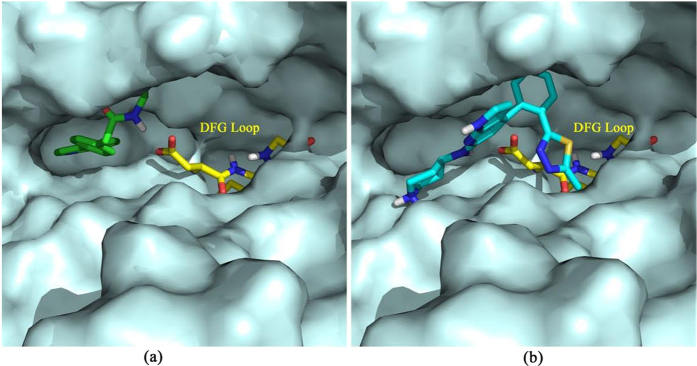
The binding pocket of ROCK1 represented by solvent-accessible surface for (a) TS-13 and (b) TS-20.